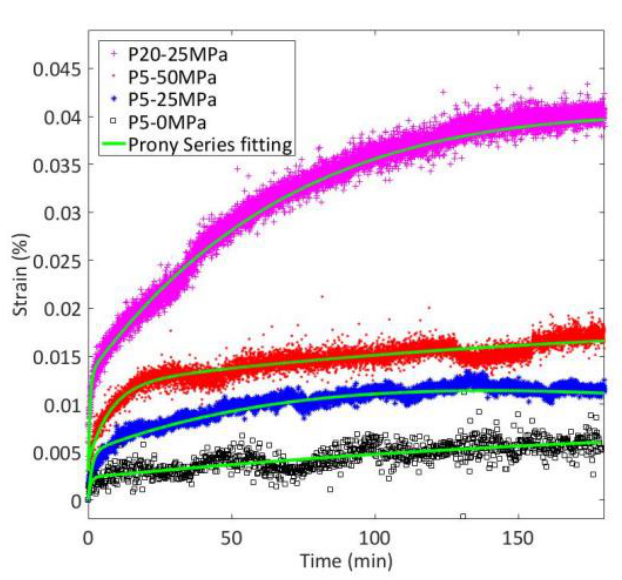
Figure 8. Axial strain deformation of ( a ) LSCF-P5 and ( b ) LSCF-P20 samples without applied compression stress superimposed with a simulated strain and temperature measurement during the experiment.